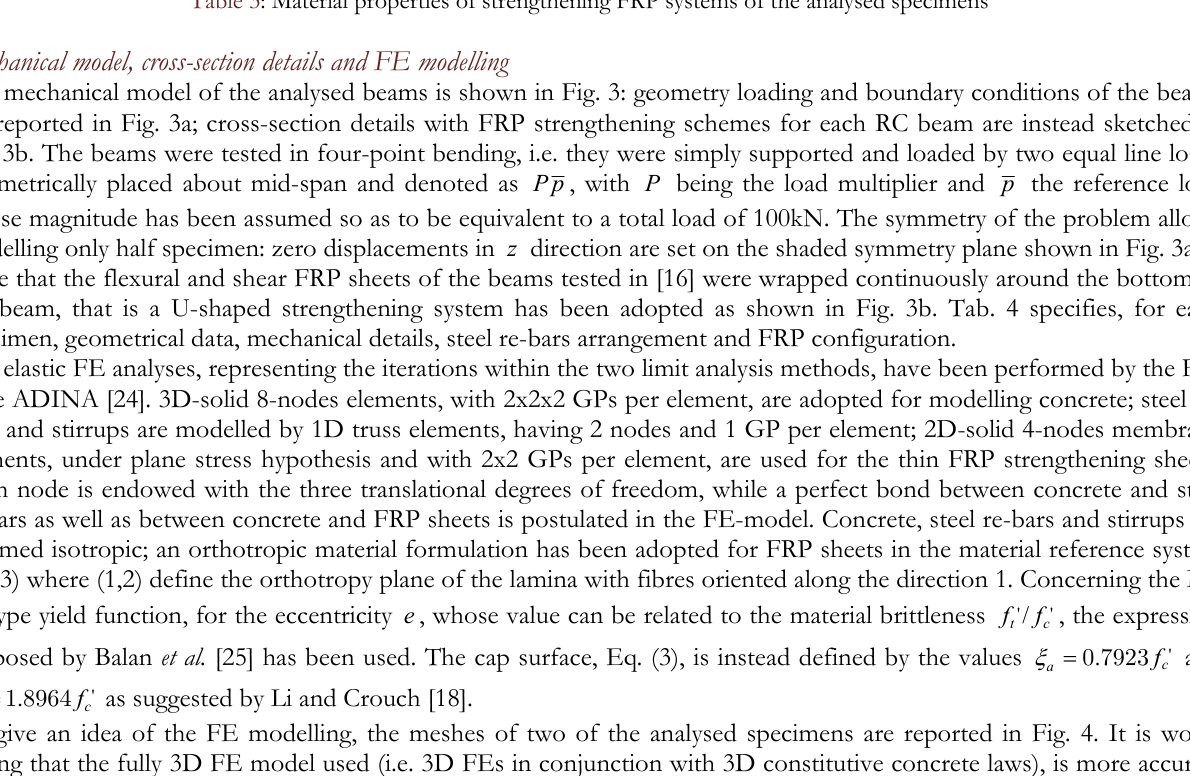
Table 3: Material properties of strengthening FRP systems of the analysed